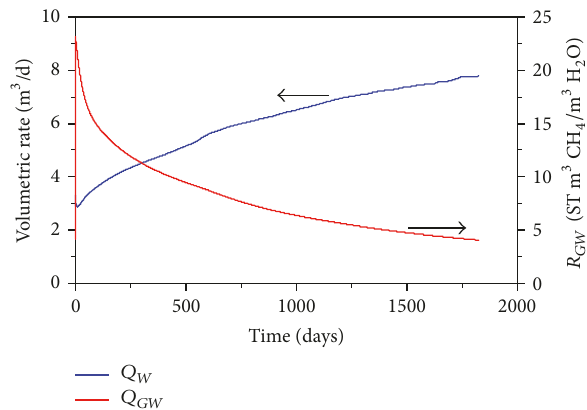
Figure 6: Evaluation of methane gas production rate ( 𝑄 𝑃𝐺 ), the dissolvedmethaneproductionrate( 𝑄 𝑃𝐴 ),thetotalmethaneproduc- tionrate( 𝑄 𝑃𝑇 ),andthecumulativemethanevolumeproducedatthe well ( 𝑉 𝑃𝑇 ) during gas production from horizontal strata.